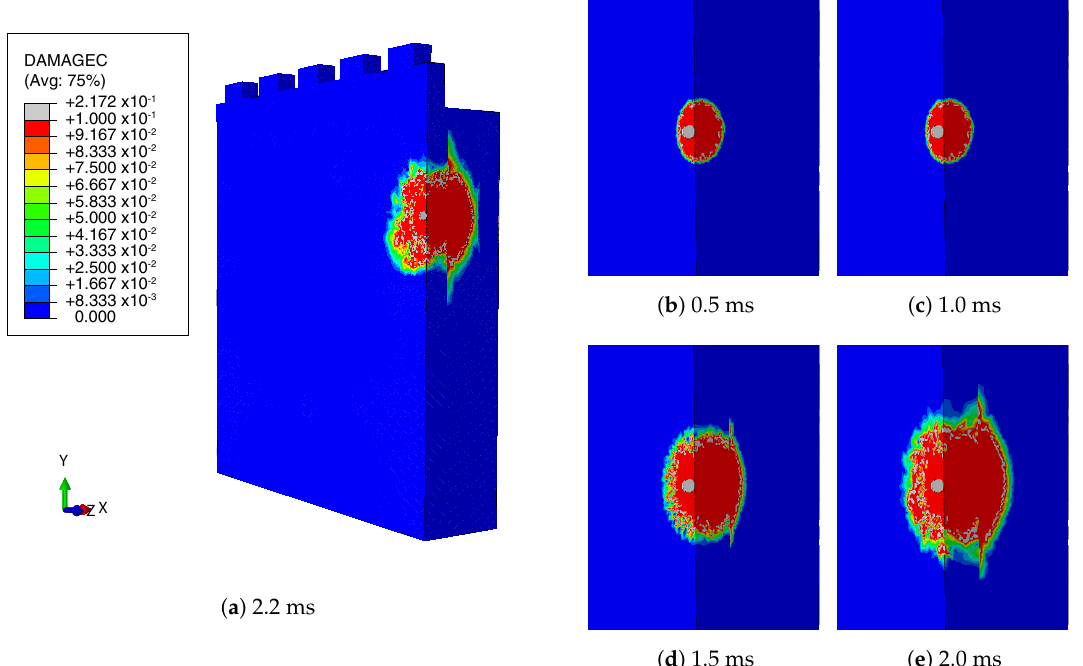
Figure 6. Maps of the compressive damage ( d c ) and zoom on the impact point at different instants of